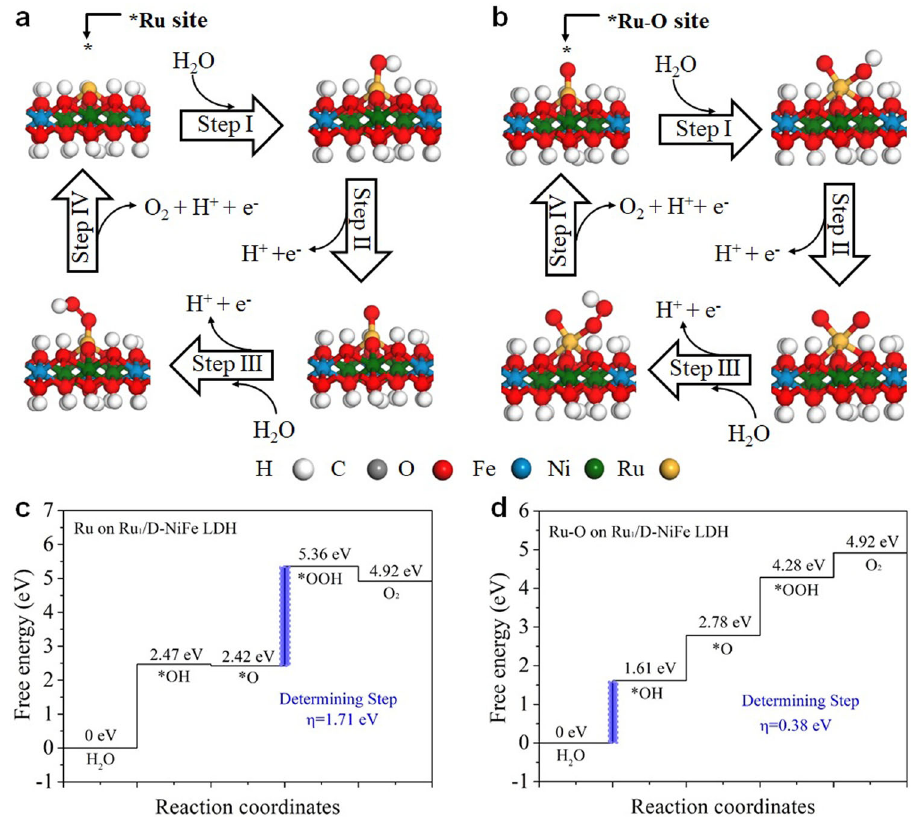
Fig. 6 DFT calculations. a , b Schematic illustration of the proposed OER mechanism and c , d Gibbs free energy diagram for a , c Ru and b , d Ru – O sites on Ru 1 /D-NiFe LDH. The lavender box step is the rate-determining